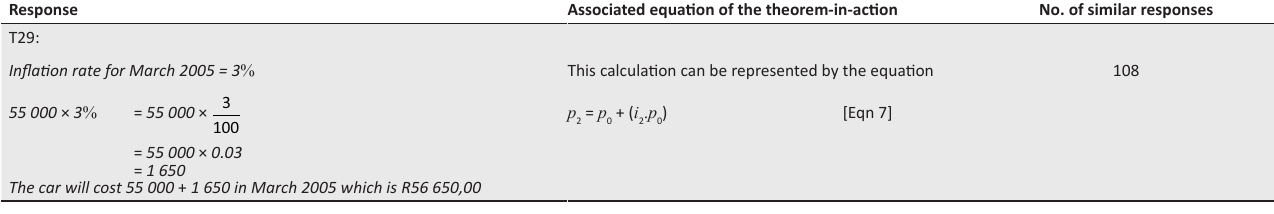
TABLE 1: Response showing a one-step